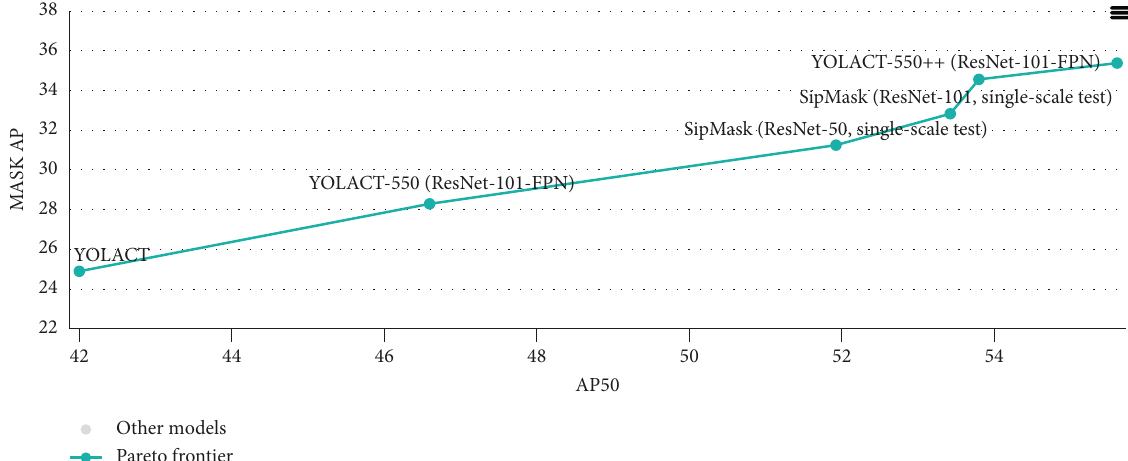
Figure 4: Performance comparison of real-time instance segmentation techniques including YOLACT/YOLACT-550 (ResNet-101), SipMask (ResNet-50)/SipMask (ResNet-101), and YOLACT-550++ (ResNet-101-FPN) [58] on the COCO dataset.